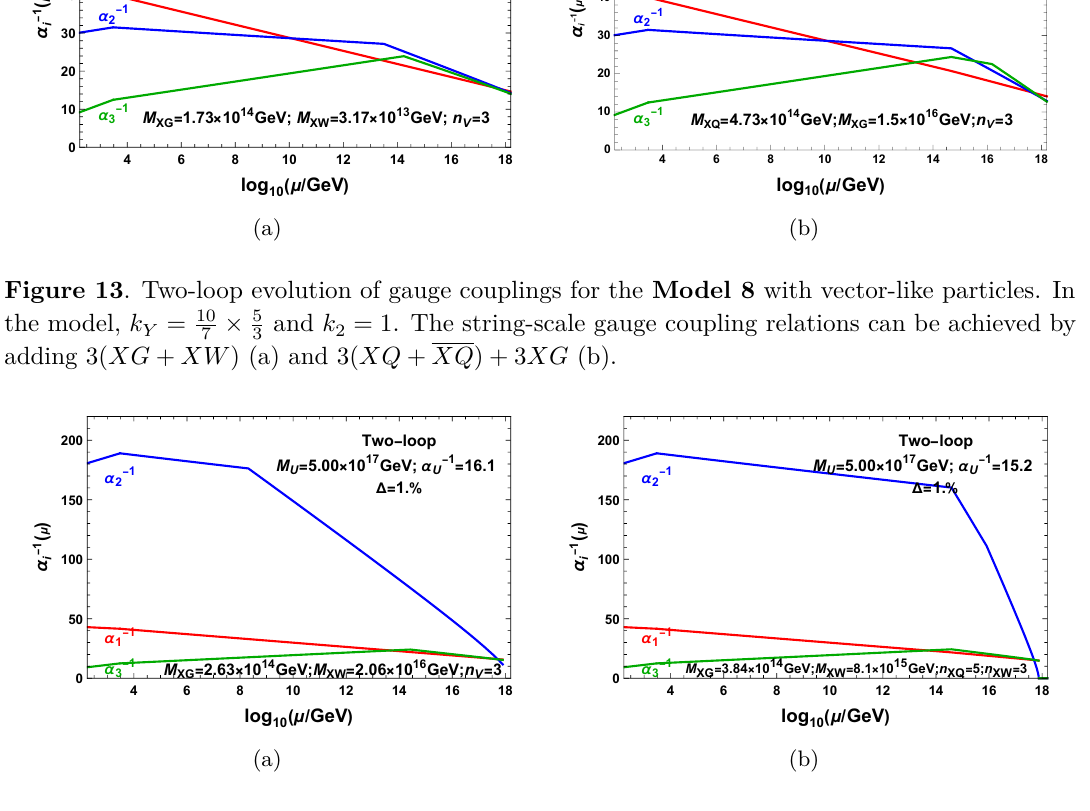
Figure 14 . Two-loop evolution of gauge couplings for the Model 9 with vector-like particles. In the model, k = 11 × 5 and k = 1 . The string-scale gauge coupling relation can be achieved by Y 2 8 3 6 adding 3( XG + XW ) (a) and 5( XQ + XQ ) + 3 XW (b).